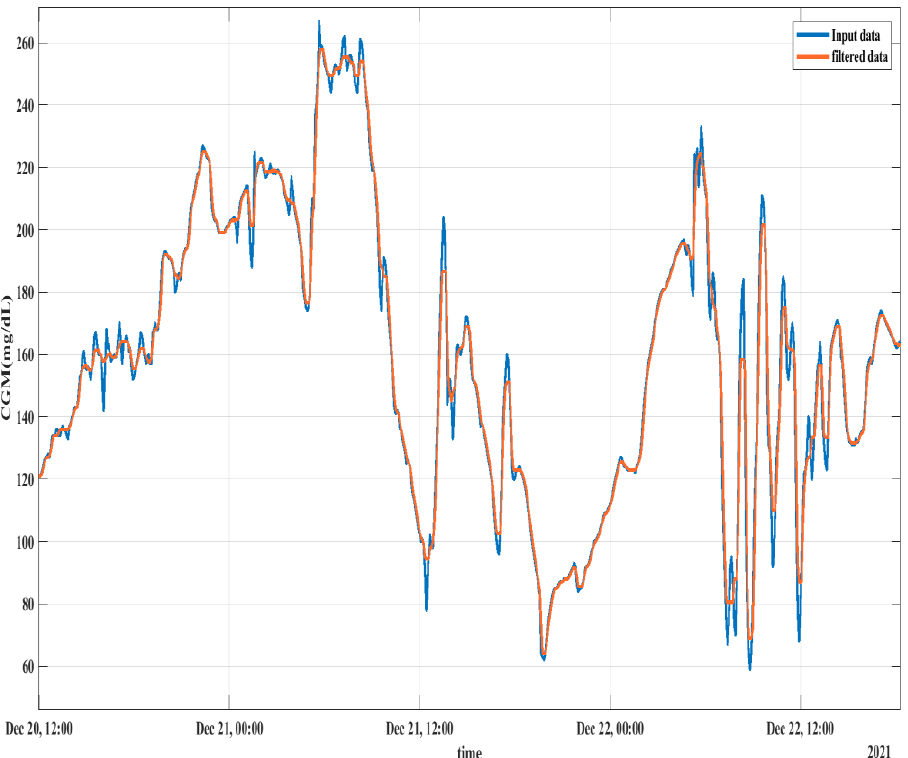
Figure 4. Data smoothing using median filtering.